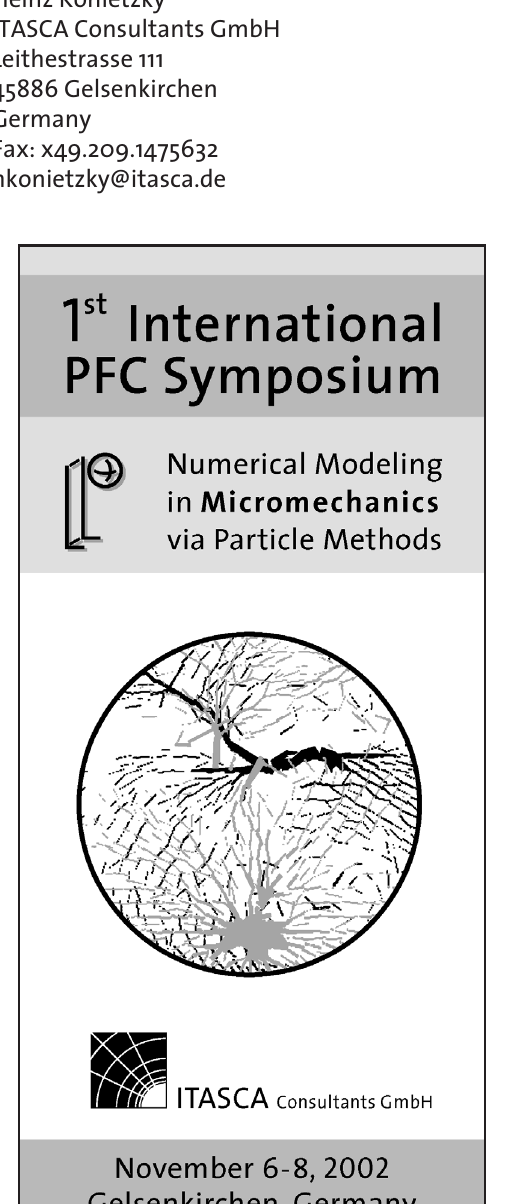
Figure 3 (left): Evolution of model experiment in steps of 100 km convergence: a) no surface erosion, b) symmetric surface erosion, c) erosion focussed on pro-wedge, d) erosion focussed on retro-wedge (Vietor